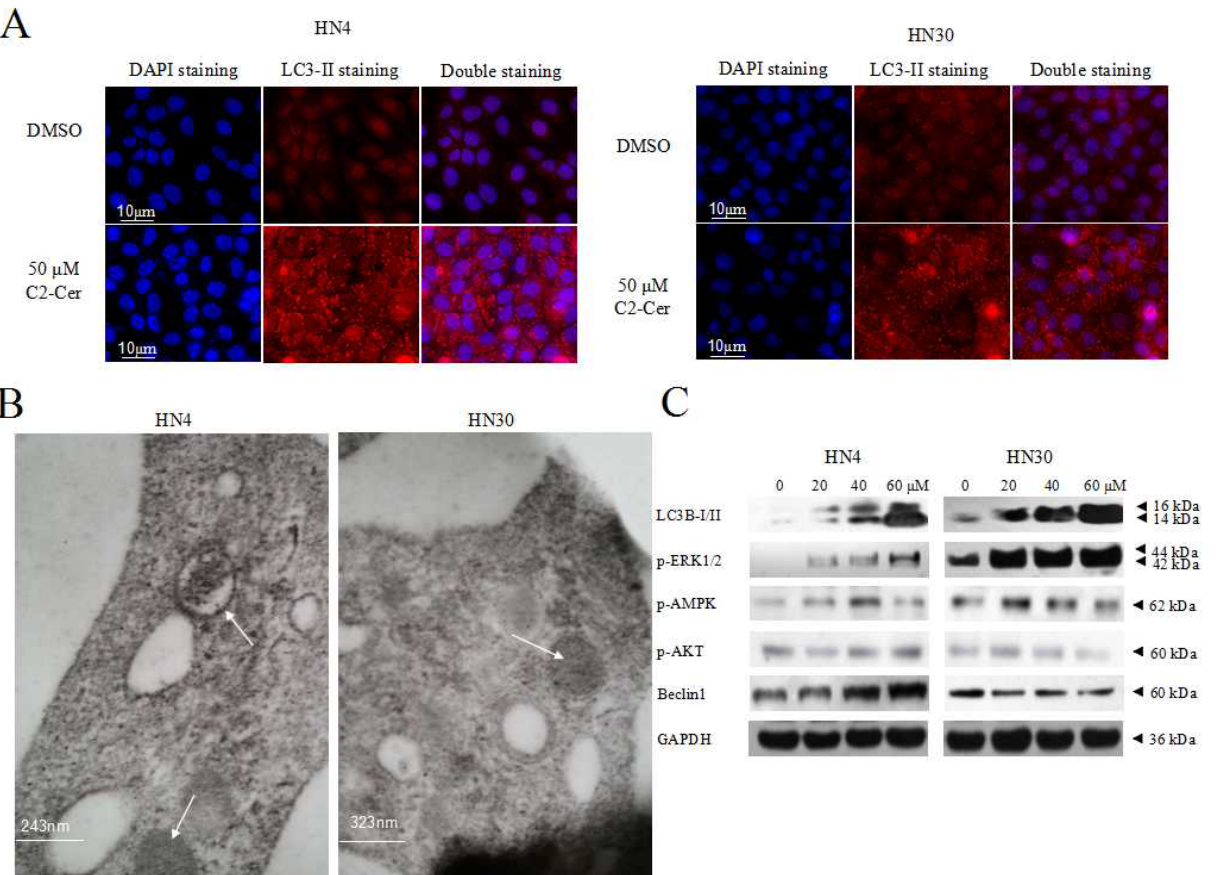
Figure 5. ( A ) DAPI/LC3-II (4',6-diamidino-2-phenylindole/microtubule-associated protein 1 light chain 3-II) double staining. LC3-II-stained particles accumulated in the cytoplasm of treated cells compared with control cells; ( B ) Electron microscopy. Cells were treated with 50 μ M C2-Cer for 4 h. Specific autophagic vacuoles accumulated in the cytoplasm